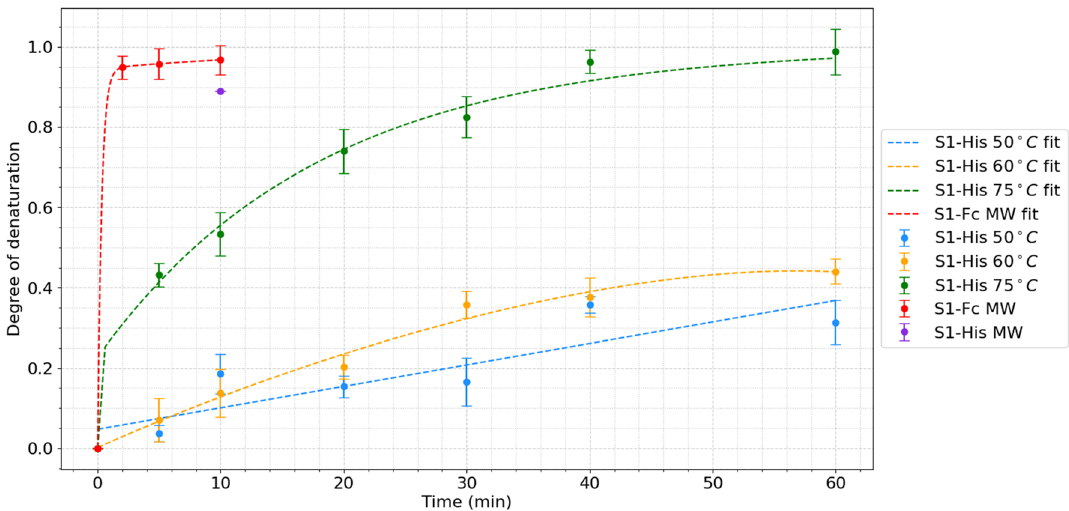
Figure 3. Degree of denaturation due to thermal heating of the S1 subunits compared to microwave radiation (37 °C) for each average temperature and time